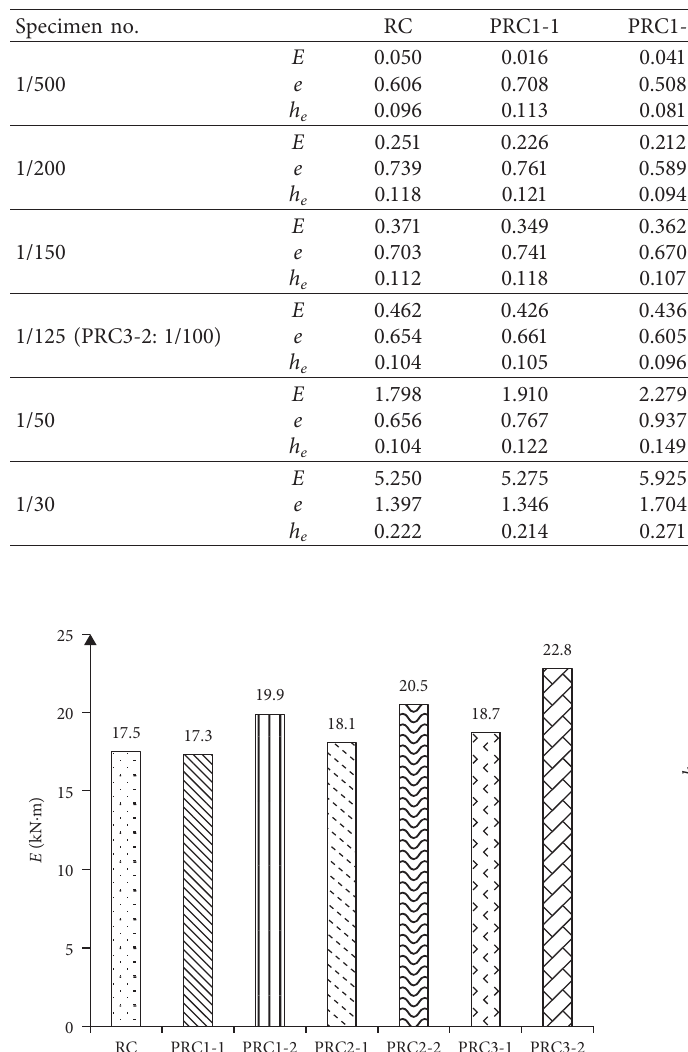
Table 5: Cumulative hysteretic energy dissipation E (kN · mm), energy dissipation coefficient e , and equivalent viscous damping coefficient h of specimens.